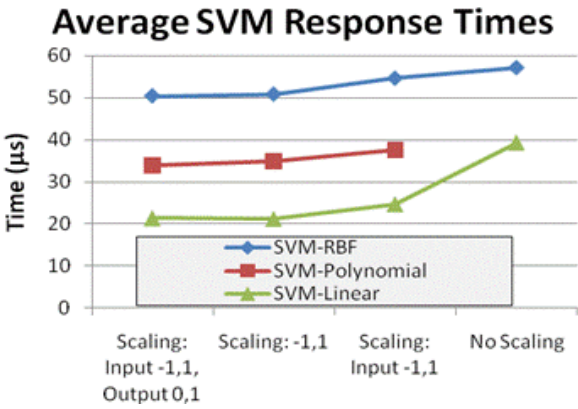
Fig. 6: SVM Average Response Times ( μ seconds)